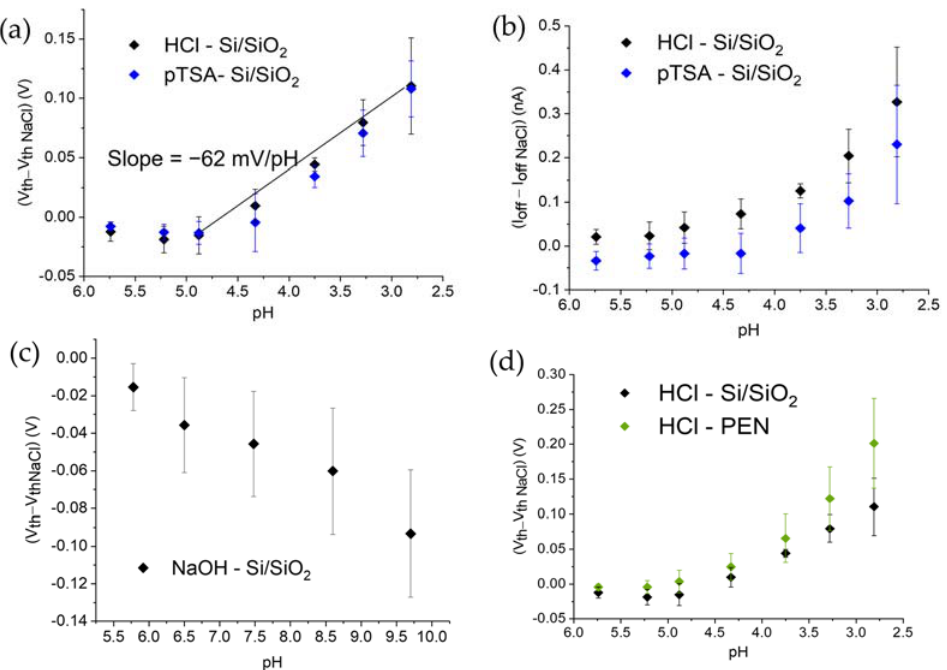
Figure 3. The pH dependence of ( a ) the threshold voltage shift; ( b ) the off-current shift. Black dots correspond to the data obtained using hydrochloric acid and blue dots—for the data obtained with pTSA. The devices were manufactured on Si/SiO 2 substrates and averaged over 5 different devices for HCl acid and for 4 devices for pTSA. ( c ) The pH dependence of the threshold voltage shift for the experiments with NaOH adding for devices manufactured on Si/SiO 2 substrate and averaged over 4 different devices. ( d ) The pH dependence of the threshold voltage shift during addition of HCl acid for the devices on PEN substrate (green dots) and Si/SiO 2 substrates (black dots). Each point on the plot represents a mean value and error bars correspond to the standard deviation of the data obtained.